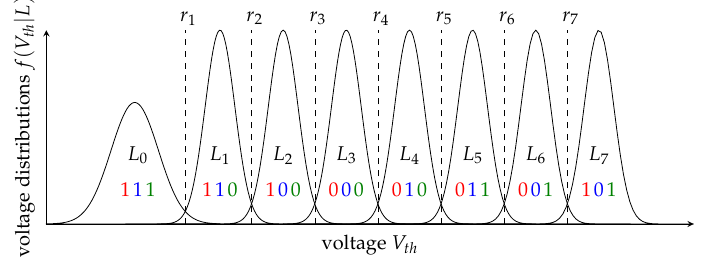
Figure 1. Model of the voltage distribution of a TLC flash memory with labeled reference threshold Figure 1. Model of voltage distribution of a TLC flash memory with labeled reference threshold voltages (dashed lines) and bit labeling. voltages (dashed lines) and bit corresponds to the end of life (EOL) defined by the manufacturer.Note that only the charged states L 1 to L 7 are shown. The voltages are represented by the index numbers of the possible voltage steps.